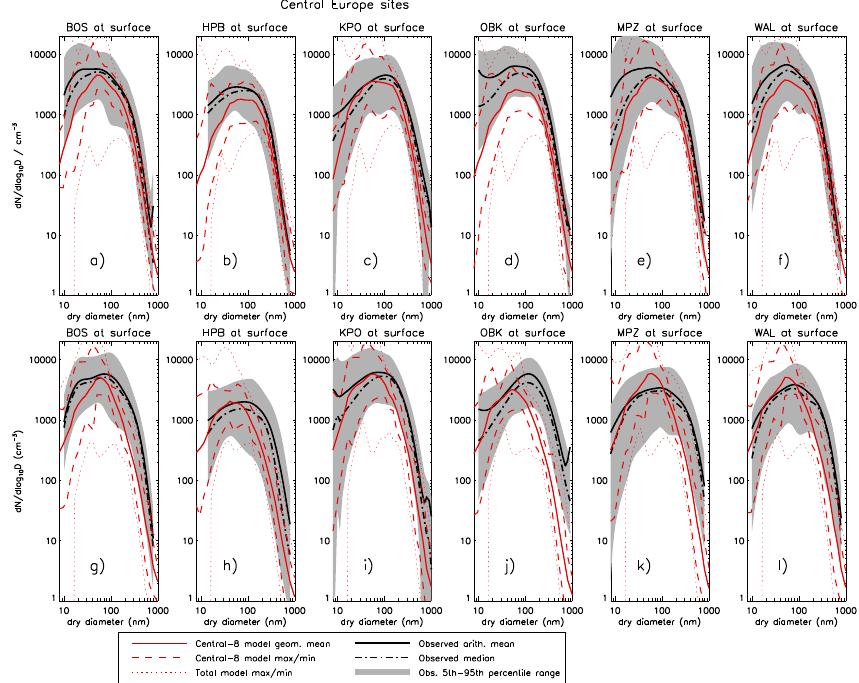
Figure 16. Summer (a–f) and winter (g–l) multi-model simulated size distributions against DMPS/SMPS measurements at the six central European EUSAAR/GUAN sites: Bosel (BOS), Hohenpeissenberg (HPB), K-Puszta (KPO), Kosetice (OBK), Melpitz (MEL) and Waldhof (WAL). Shown are the central-8 model geometric means (red solid) central-8 model maximum/minimum (red dashed) and all-12 model minimum/maximum (red dotted) of the June–July–August (arithmetic) mean size distributions at each site. Observed values (black solid line) are arithmetic means over the hourly measurement data (A. Asmi, personal communication, 2012). The published (Asmi et al., 2011) median (black dot-dashed) and 5th to 95th percentile range (grey shading) over the hourly measurement data are also shown for reference.